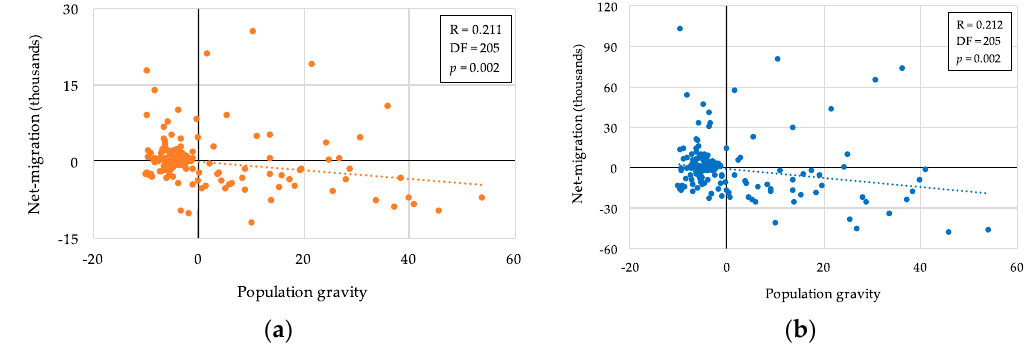
Figure A6. Population gravity at 2010 by traditional gravity model with exponential function and